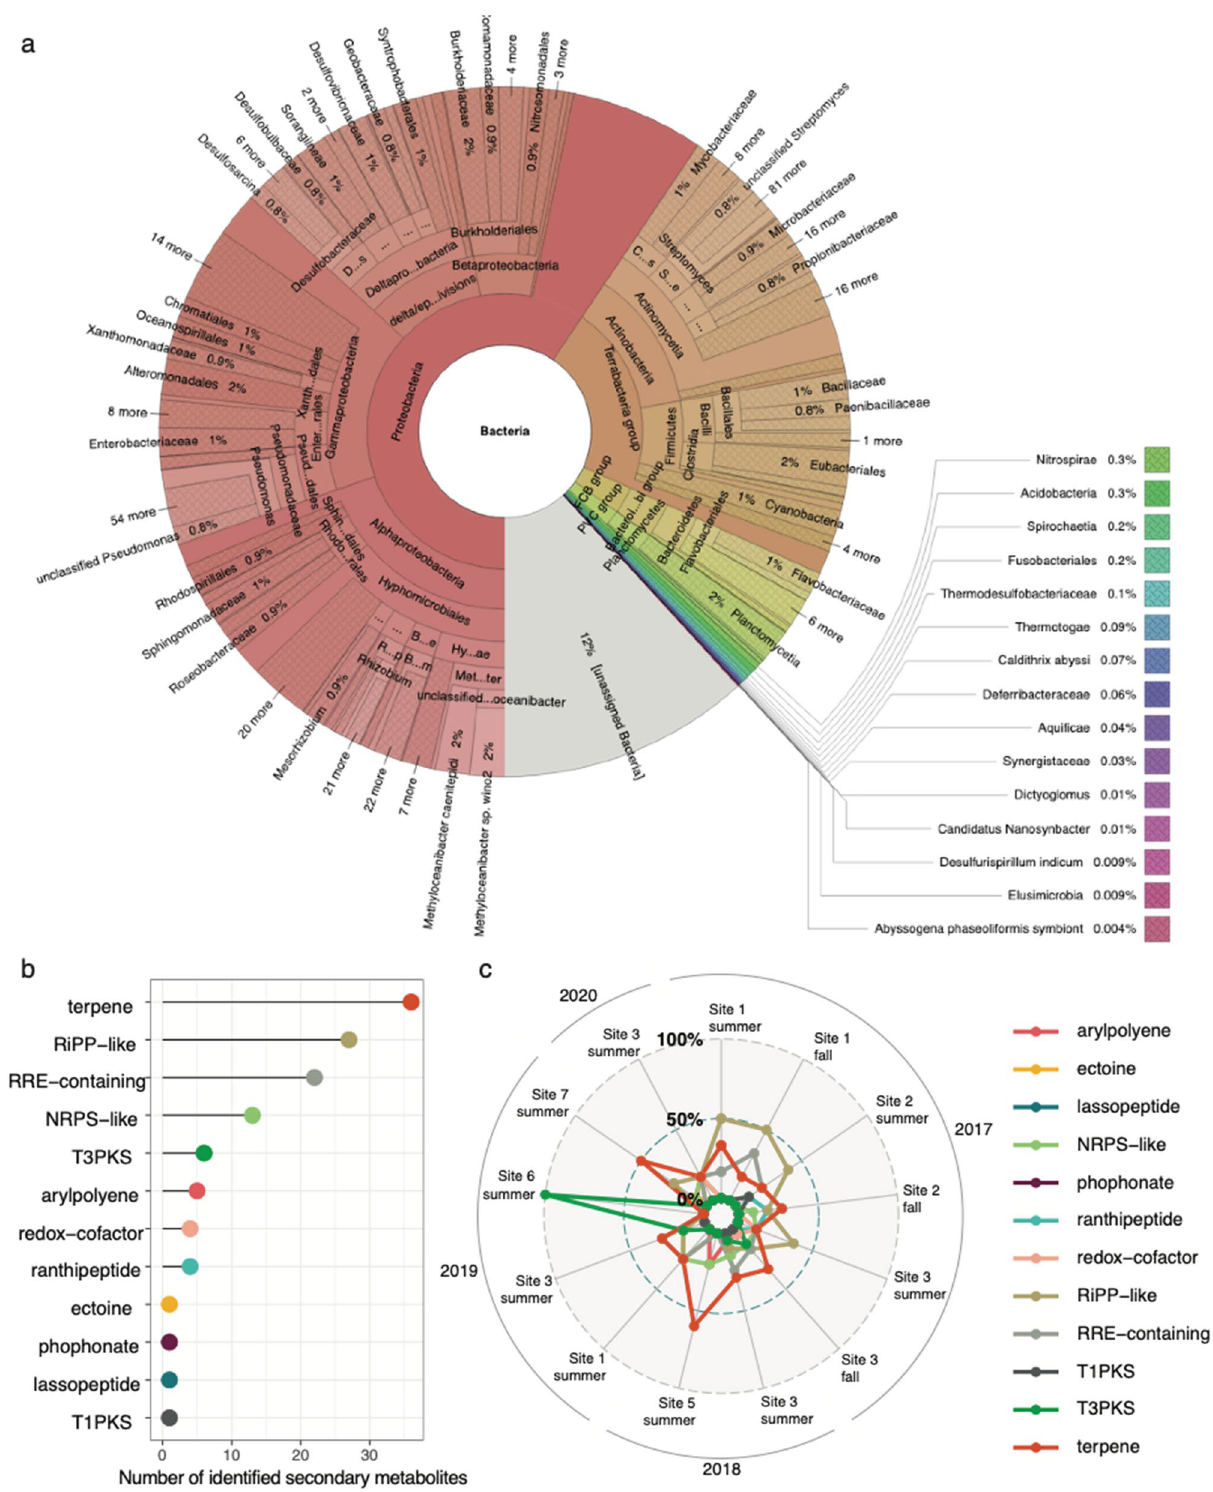
Figure 6. Taxonomic composition of high-quality metagenomes (MAGs) collected across all sample sites in this study, estimated with Kraken2 and visualized with KronaTools ( a ). Lollipop plots describing the number of BGCs detected across all sample sites ( b ). Radar plots exhibiting the proportion of secondary metabolites identified at each sample site ( c